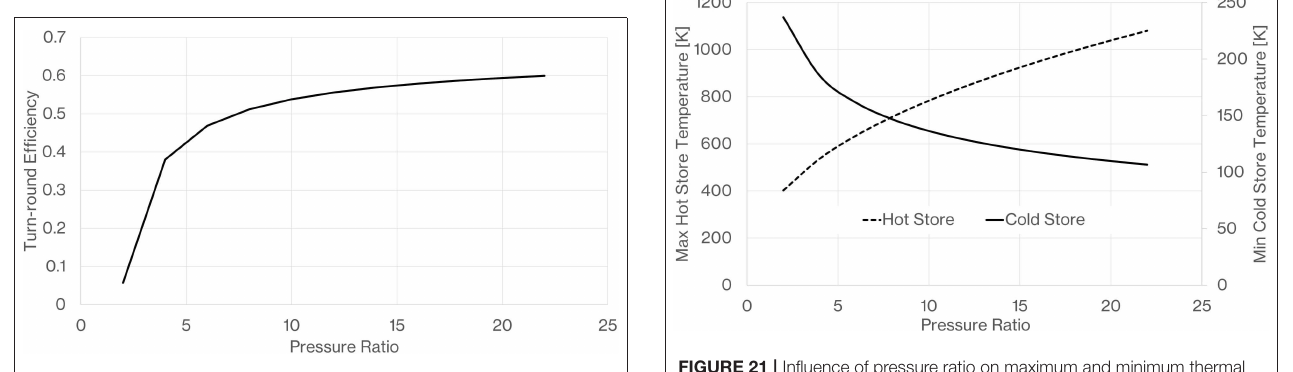
FIGURE 20 | Influence of pressure ratio on turn-round efficiency.